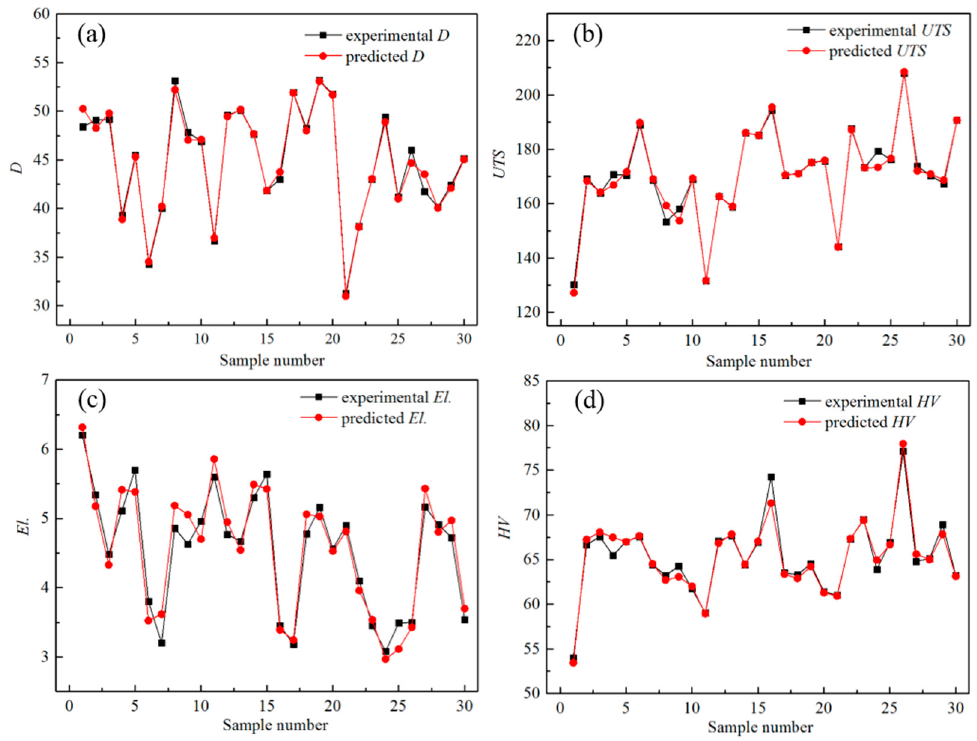
Figure 10. The comparisons between the experimental and the predicted results for the entire datasets. ( a ) D , ( b ) UTS , ( c ) El. and ( d ) HV .